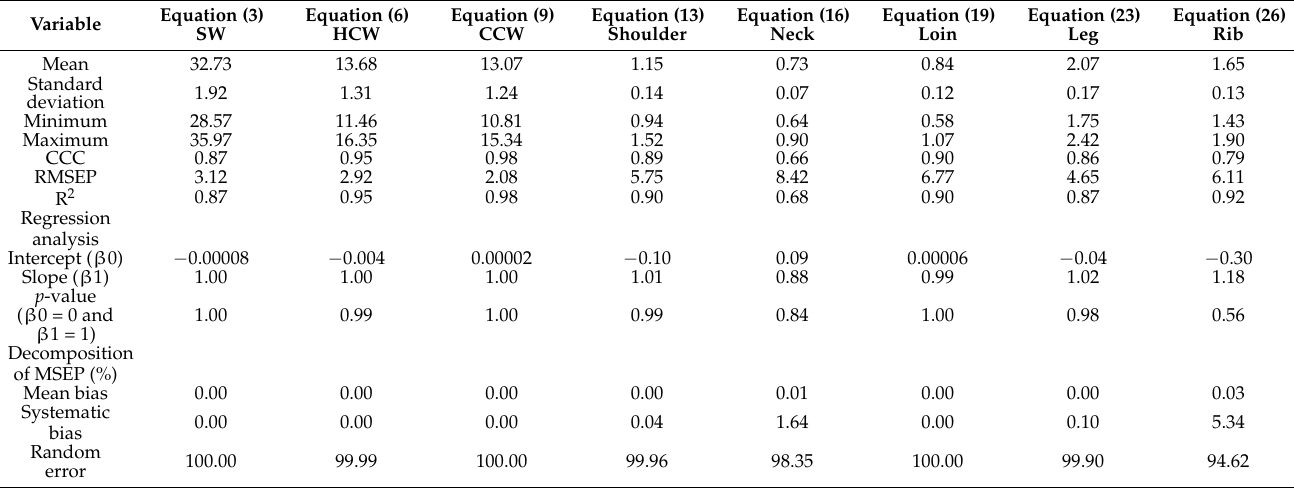
Table 5. Mean and descriptive statistics of the fit of equations for predicting carcass traits of sheep in finished tropical pastures through biometric